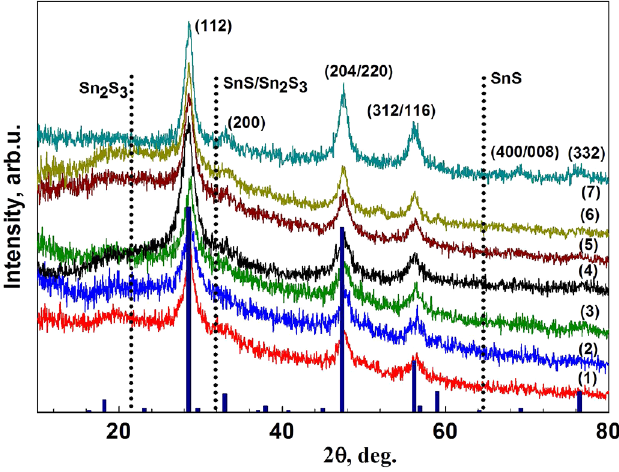
Fig. 2. The XRD data of CZTS samples on glass